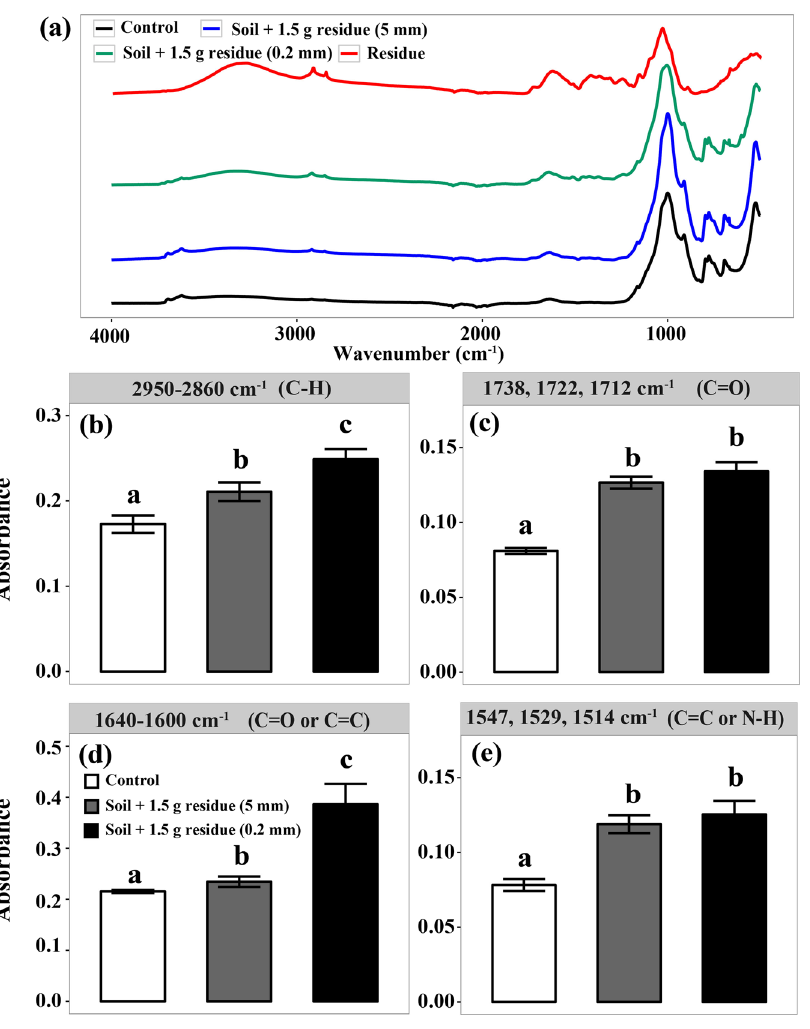
Figure 5. Attenuated total reflectance-Fourier transform infrared spectroscopy (ATR-FTIR) for the samples with the highest residue addition rate treatments after incubation for 105 days ( a ). Signal intensities of C–H groups ( b ), C = O groups ( c ), C = O or C = C groups ( d ) and C = C or N–H groups ( e ).